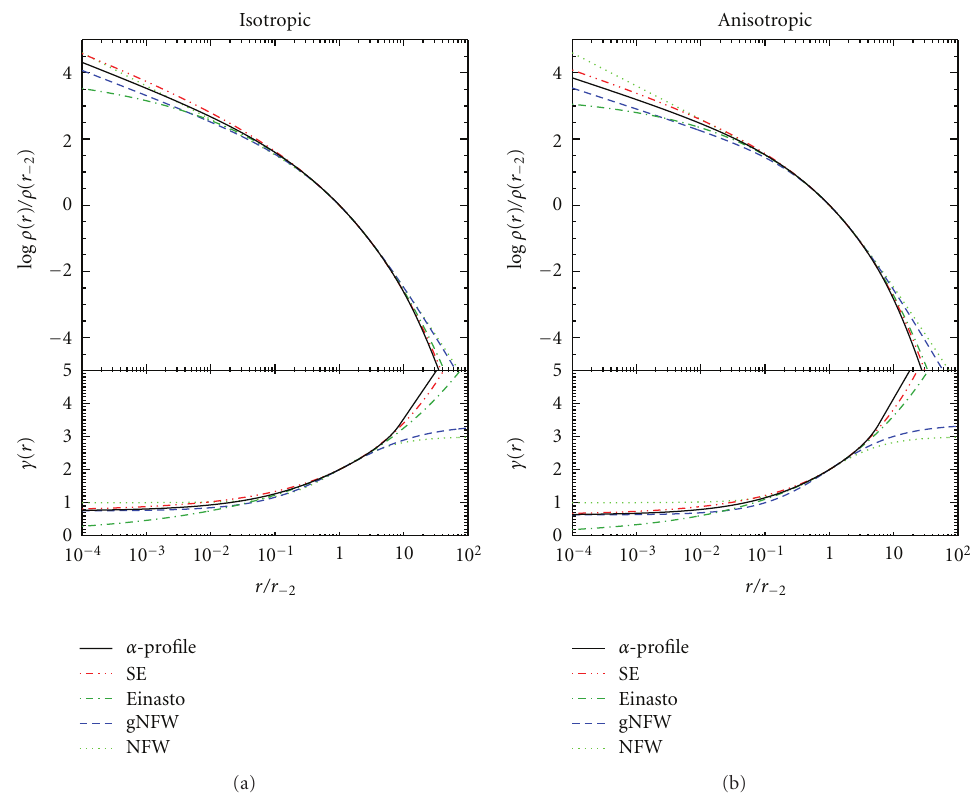
Figure 1: Density profiles in isotropic (a) and anisotropic conditions (b) for the dynamical model and its approximation in terms of empirical models with the parameters derived in Section 4 and summarized in Tables 1 and 2. The lower panels highlight the corresponding logarithmic density